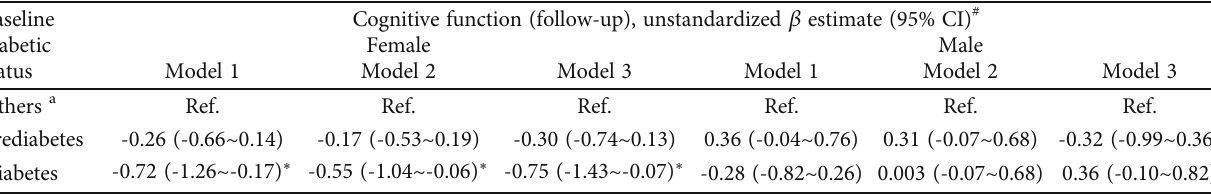
Table 3: Eight-year association between baseline diabetic status and subsequent cognitive function according to biological sex.